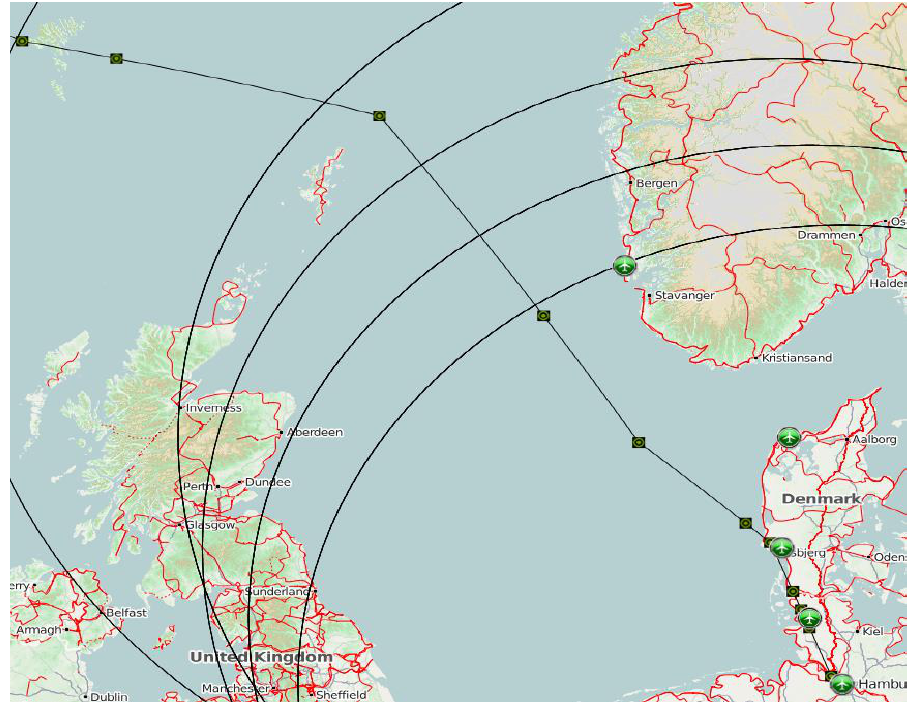
Figure 5. Emergency airfield selected for the RQ-4 A engine failure contingency.